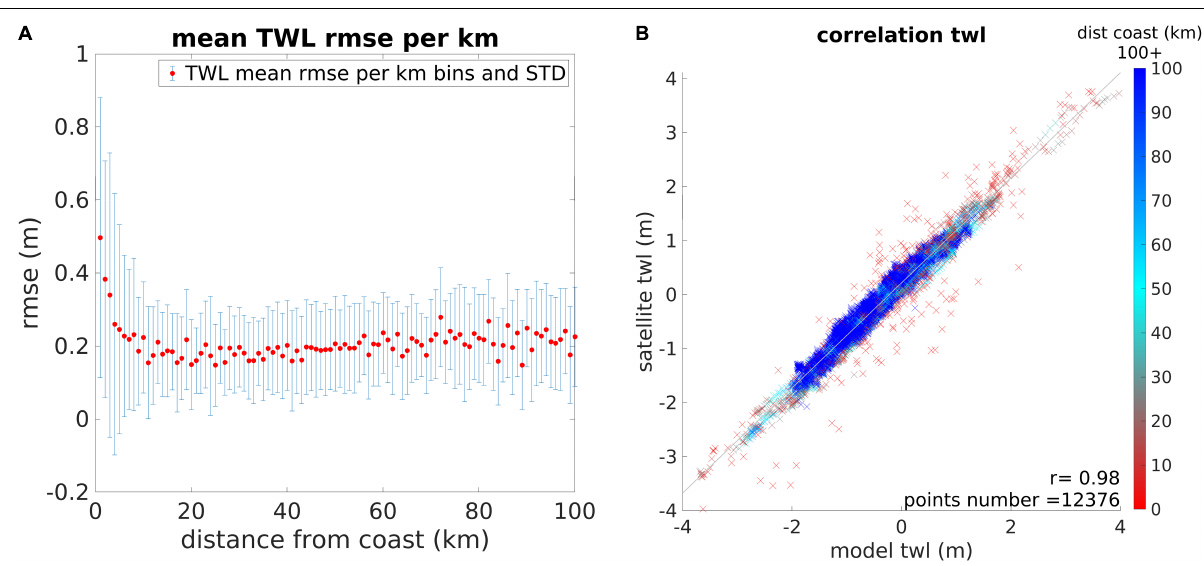
FIGURE 10 | (A) RMSE of the TWL difference between S3 and Amm15 as function of the distance from the coast. This example is from February 2017. (B) Correlation between satellite and model data with color indicating distance to the coast from (blue) all data further than 100 km from the coast to (red) data at the coast. The RMSE in the right plot was averaged per kilometer